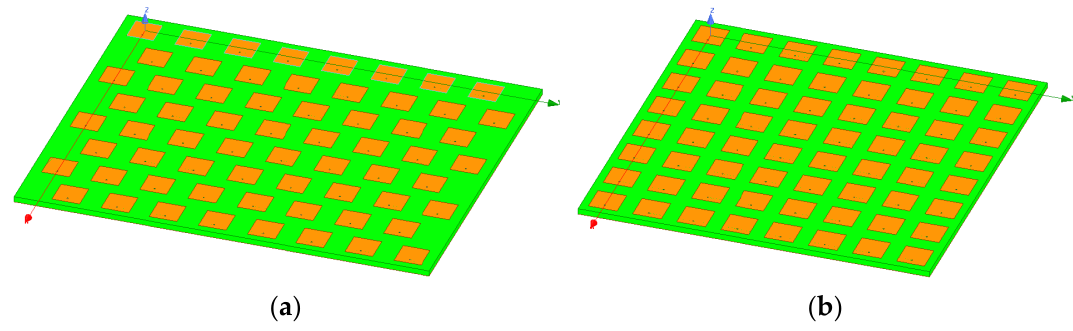
Figure 11. Planar array with 64 elements arranged with ( a ) an equilateral triangular lattice; and ( b ) a square lattice. Table 2. Simulated mutual coupling average values ( η Sij ) among antenna elements and the maximum value comparison in dB between triangular and square lattice planar arrays composed of 64 elements (8 × 8).